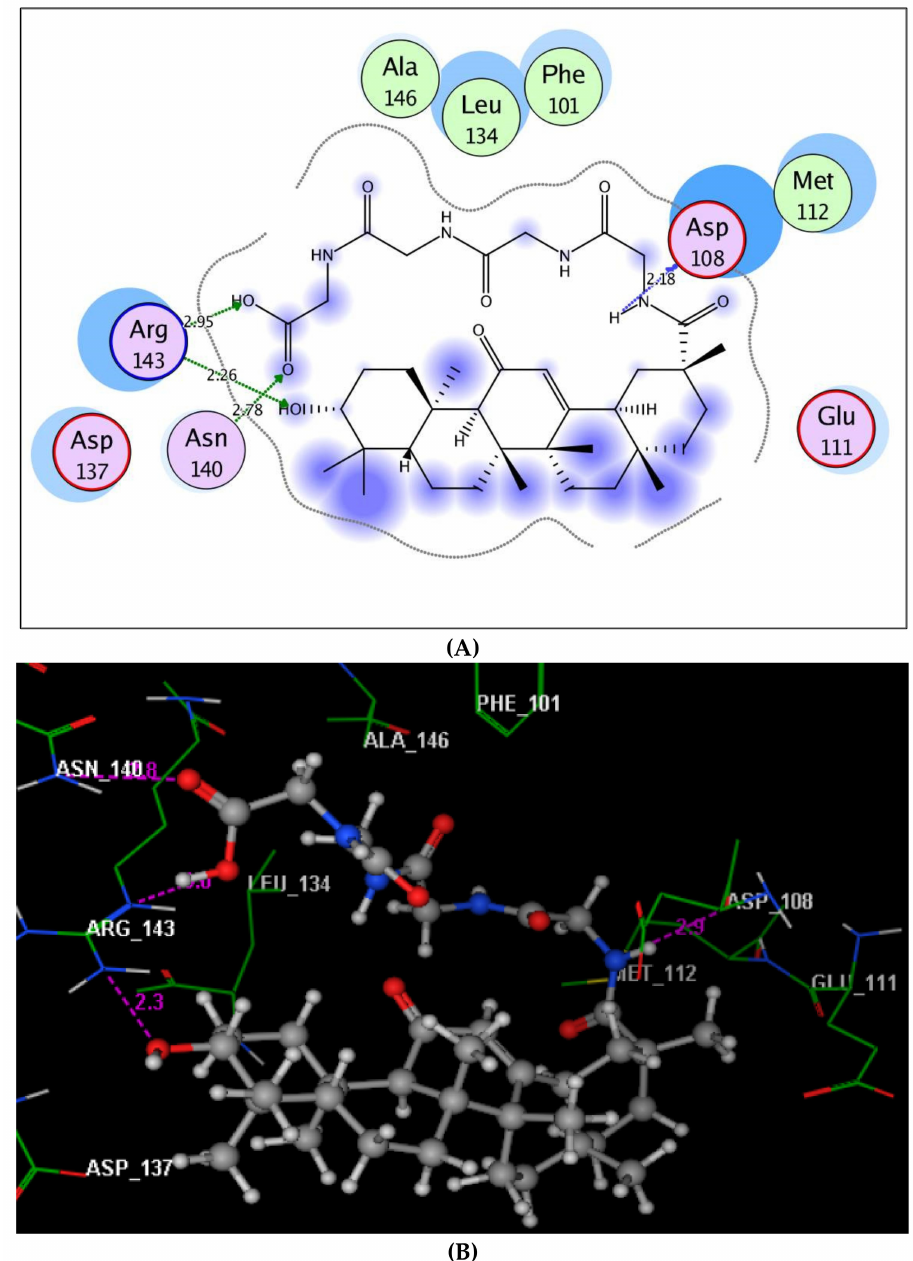
Figure 7. Maps ( A ) and ( B ) explore 2D and 3D binding modes of the promising target 5 within Table 2 (PDB: